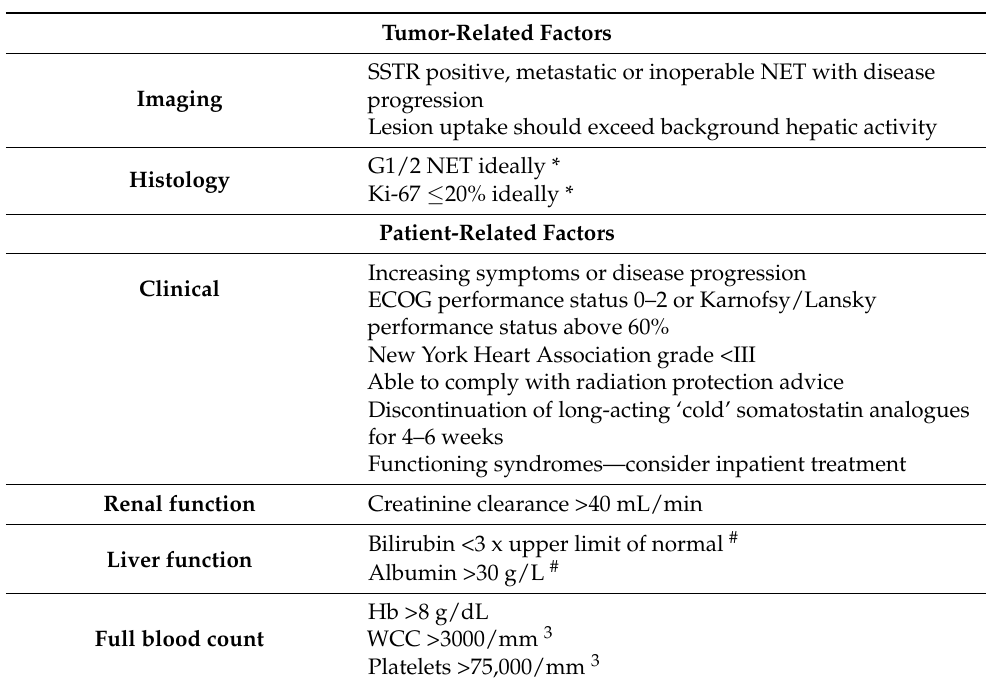
Table 2. Patient selection recommendations for 177